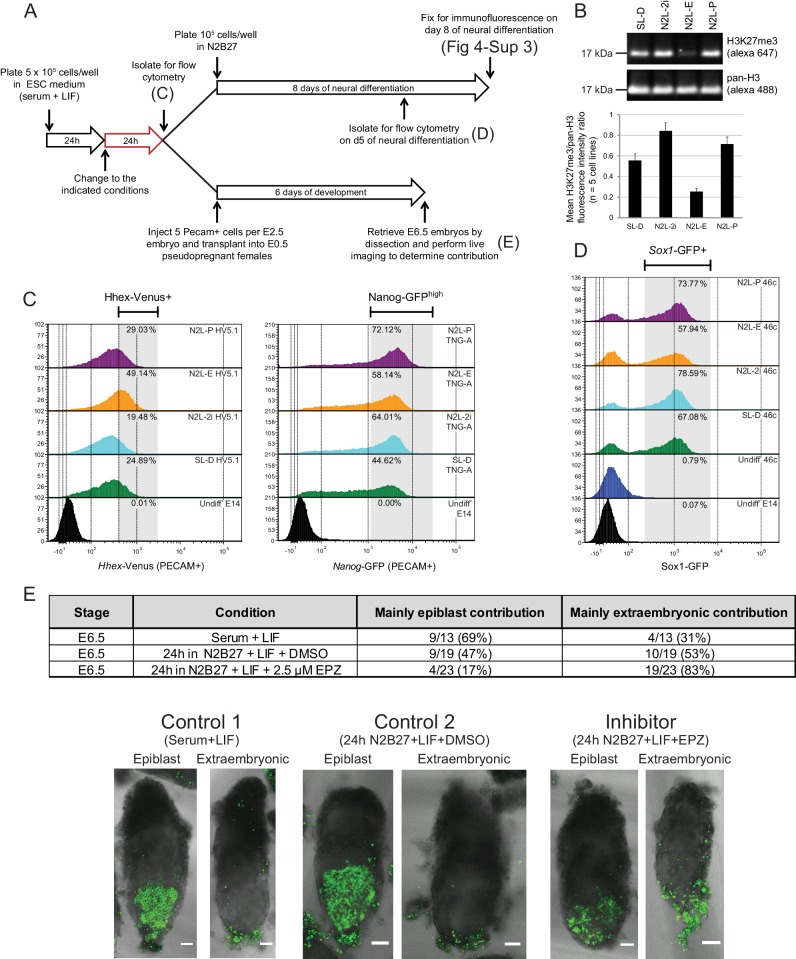
Blocking H3K27 methylation in ESCs promotes endoderm priming and the contribution to extra-embryonic endoderm in vivo.(A) Schematic overview of the experimental setup used to assess the in vitro and in vivo effects of EPZ on differentiation capacity. (B) Example immunoblot showing H3K27me3 levels relative to total H3 after 24 h of treatment in the indicated conditions. The densitometry ratio graph shows data from 5 different cell lines and error bars represent the SEM. (C) Flow cytometry after 24 h of treatment in the indicated conditions for the endoderm marker gene Hhex using HV5.1 ESCs (Hhex-IRES-Venus clone 5.1; (Canham et al., 2010)) and the epiblast marker Nanog using TNG-A ESCs (Nanog-GFP clone A; (Chambers et al., 2007)). Differentiating cells were excluded by gating for PECAM positive cells. The percentage of cells that fall within the indicated gate is shown in the upper right corner of each histogram. (D) Flow cytometry for the early neural marker Sox1 on 46c cells (Sox1-GFP; [Ying et al., 2003]) after 24 h of treatment in the indicated conditions followed by 5 days of neural differentiation. See also Figure 4—figure supplement 3. (E) Table showing the quantification of developmental potential, based on scoring E6.5 chimeric embryos as presenting with either ‘mainly epiblast’ or ‘mainly extra-embryonic endoderm’ contribution. Chi-square test result (χ2 = 9.96; p=0.007) shows a significant shift in the fraction of embryos with mainly extra-embryonic endoderm when comparing N2B27+LIF+EPZ (Inhibitor) with serum+LIF (Control 1) and N2B27+LIF+DMSO (Control 2). Representative examples of scored chimeric embryos are depicted for each condition. Treated ESC cells were FACs sorted for the cell-surface marker PECAM prior to injection into E2.5 embryos. (C–E) The conditions indicated are: N2L-P (N2B27 + LIF + 1 µM PD032); N2L-E (N2B27 + LIF + 2.5 µM EPZ6438); N2L-2i (N2B27 + LIF + 1 µM PD032 + 3 µM CHIR); SL-D (Serum + LIF + DMSO).